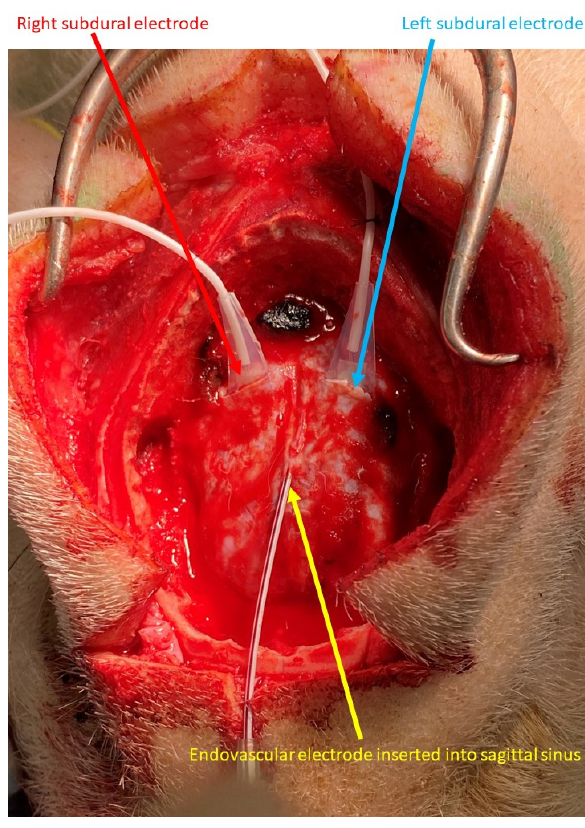
Figure 1. Endovascular and subdural electroencephalograms. Four-contact subdural electrodes were placed in each hemisphere through a linear dural incision (blue and red arrows). The endovascular electrode was inserted into the sagittal sinus through the outer needle of the venous catheter needle (yellow arrow).